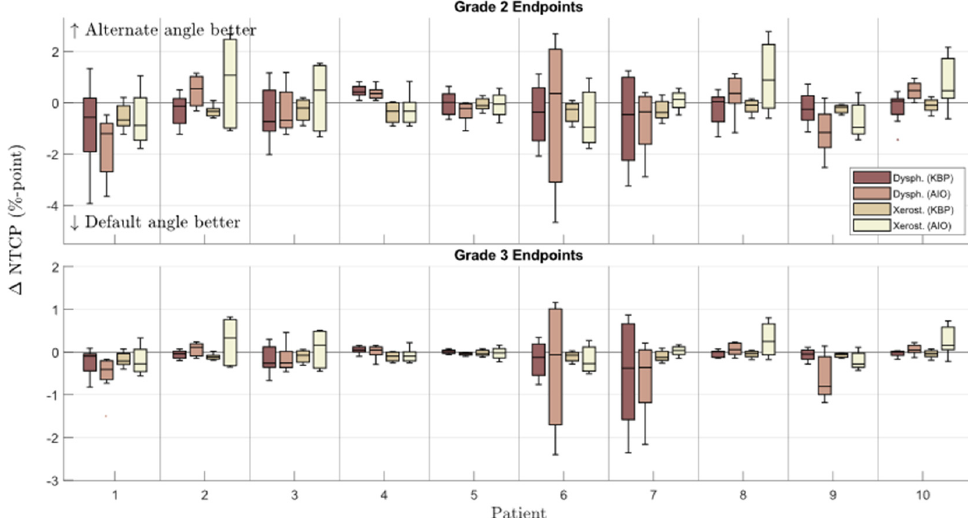
Figure 2. Box-whisker plot of patient-wise NTCP difference between KBPs/AIO plans with default and alternate beam angles (default minus altered). Dark line in the middle of the box indicates the median; the top/bottom of the box indicates 75th/25th percentile; and the whiskers indicate the range of the data. Dysph. = dysphagia; Xerost. = xerostomia; KBP = knowledge-based plan; AIO = automatic iterative optimizer ‐ generated plan; ∆ NTCP = normal tissue complication probability difference.